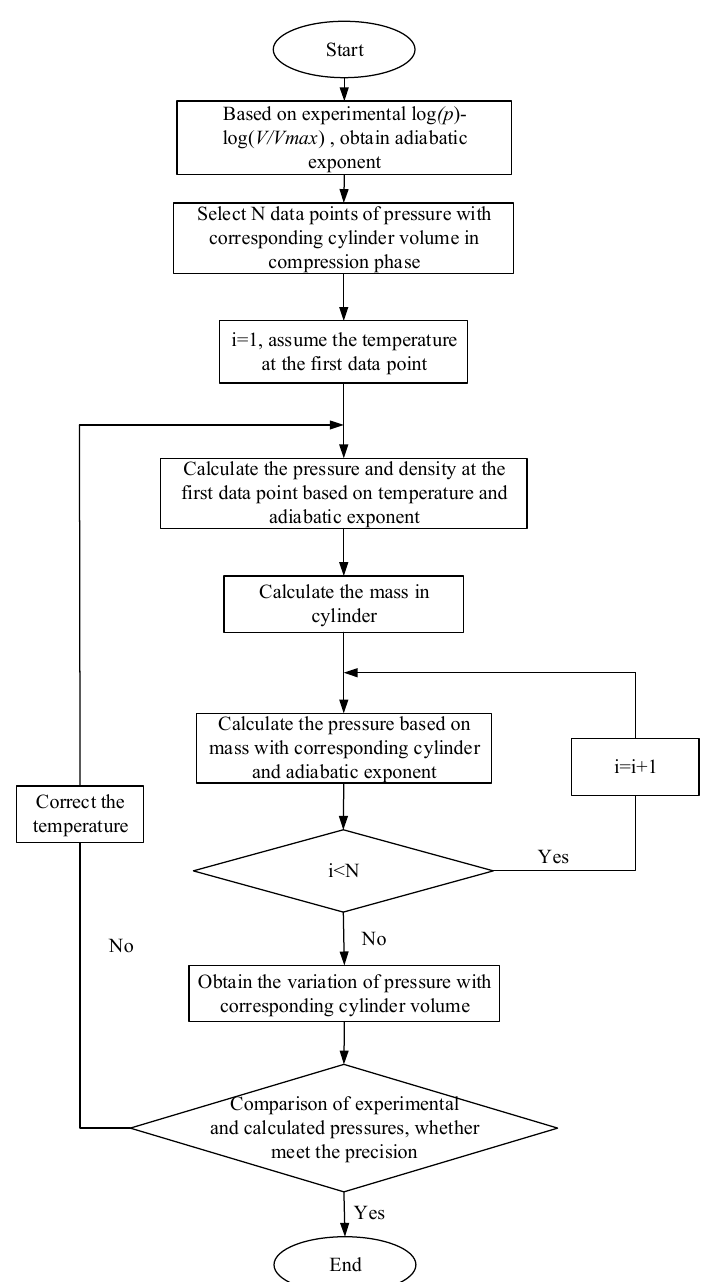
Figure 6. Flow chart for the method of calculating the refrigerant mass in the cylinder